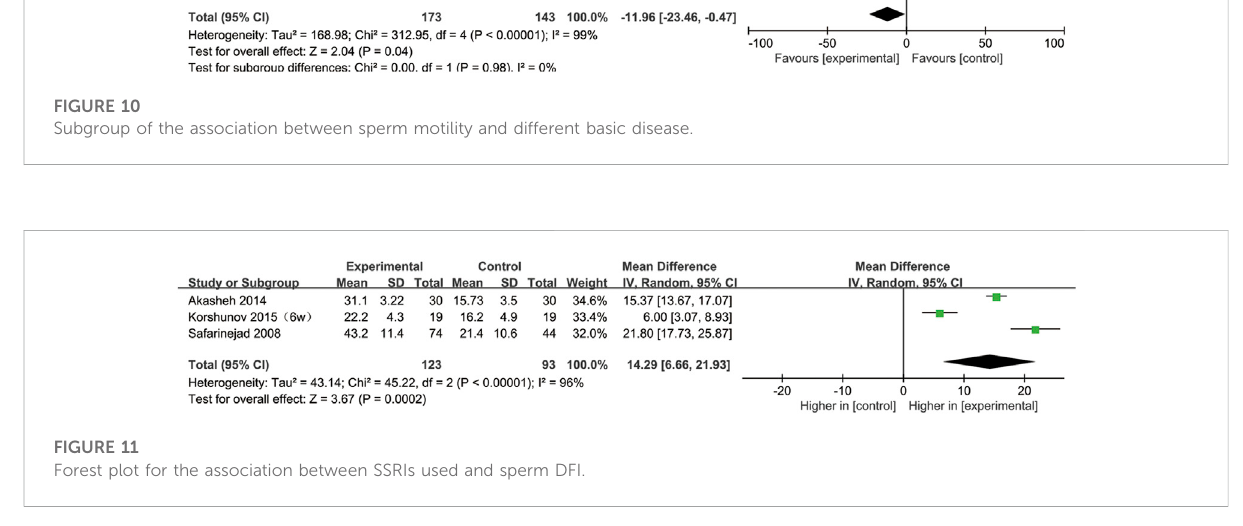
0.0002), suggesting that SSRIs had a negative effect on the DNA integrity. In the subgroup analysis of disease type, we found that SSRIs in fl uenced the DFI in patients with premature ejaculation (95% CI [13.67,17.07], p < 0.00001) but n ot in patients with depression (95% CI [ − 1.65,29.32], p = 0.08) (Figure 12).